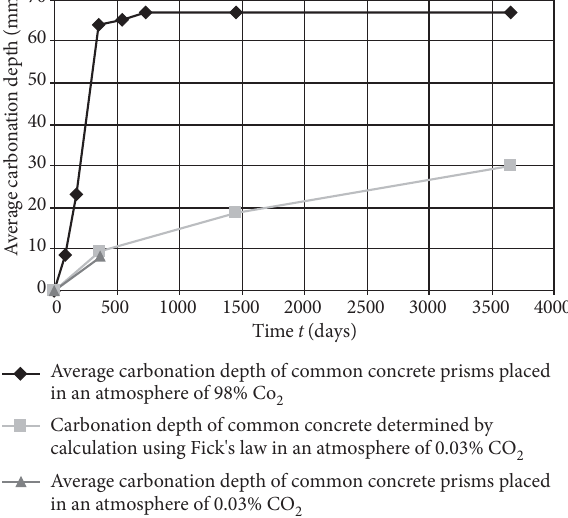
Different carbonation depths in the accelerated test under an atmosphere of 98% CO and under a common atmosphere of 0,03% CO mm )